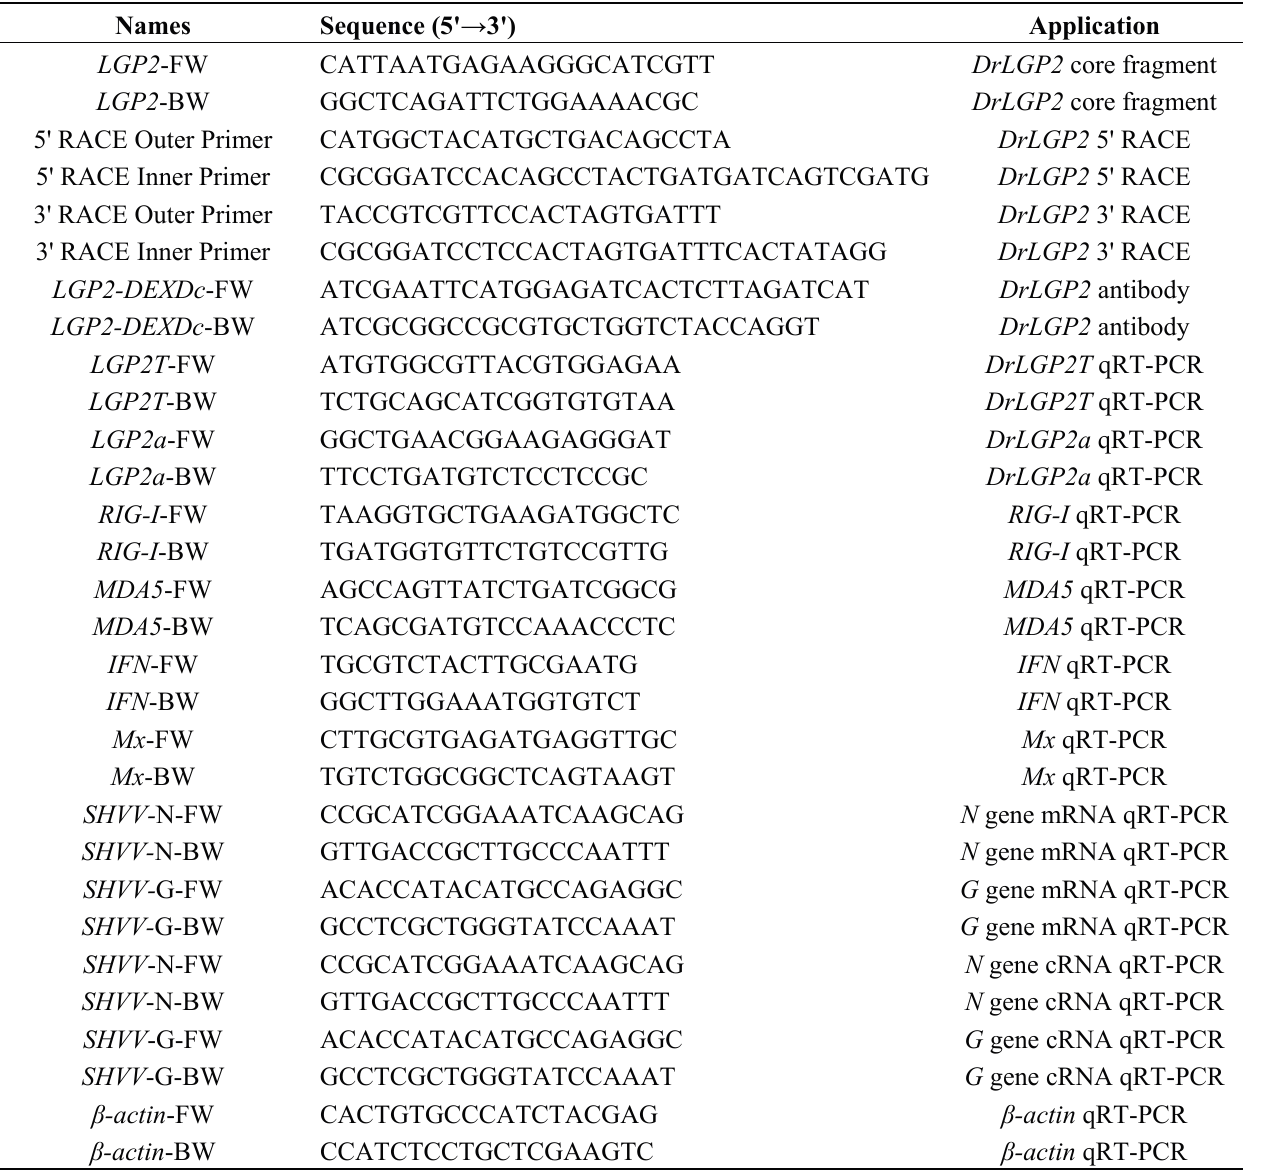
Table 1. Primers used in the